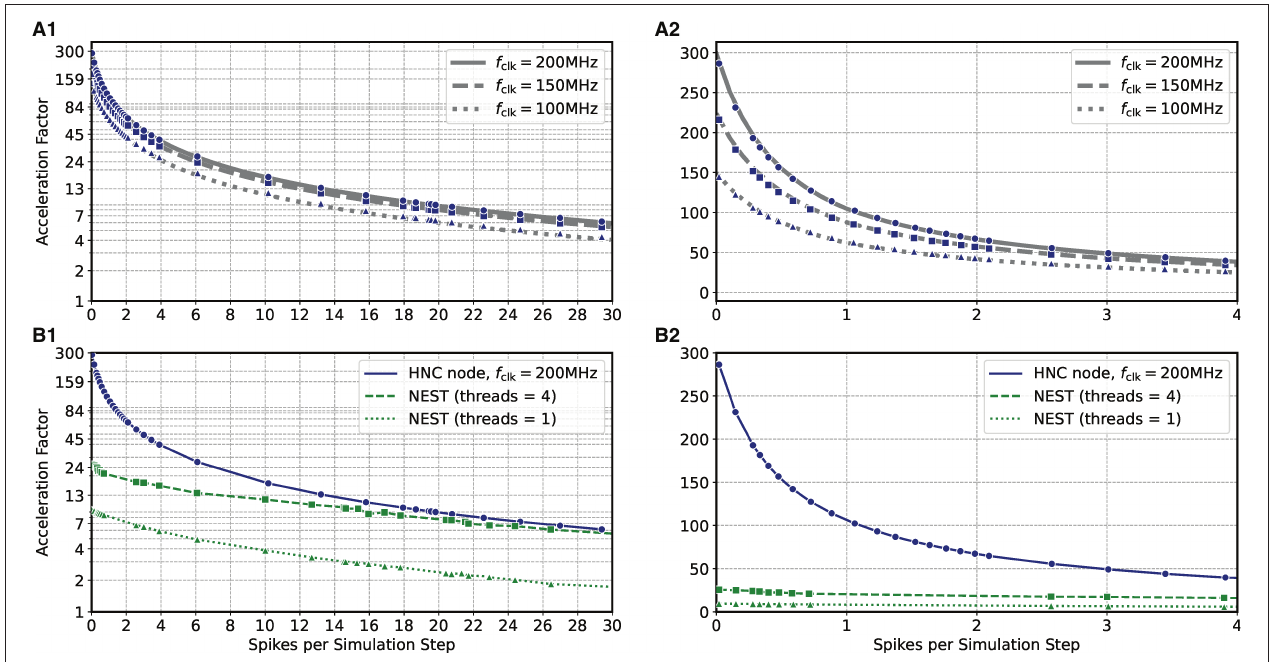
FIGURE 3 | Performance as a function of PL clock frequency and workload for the HNC node and NEST. (A) Measured acceleration factors of the HNC node (blue markers) as a function of workload for three different clock frequencies in log-lin (A1) and linear (A2) representation. Gray curves show the predictions of the performance model (Section 5.2). (B) As in (A) , but comparing the performance of the HNC node running at a PL clock frequency of f clk = 200 MHz to that of a NEST implementation using one or four threads on an Intel(R) Core(TM) i7-7700K CPU 4.20